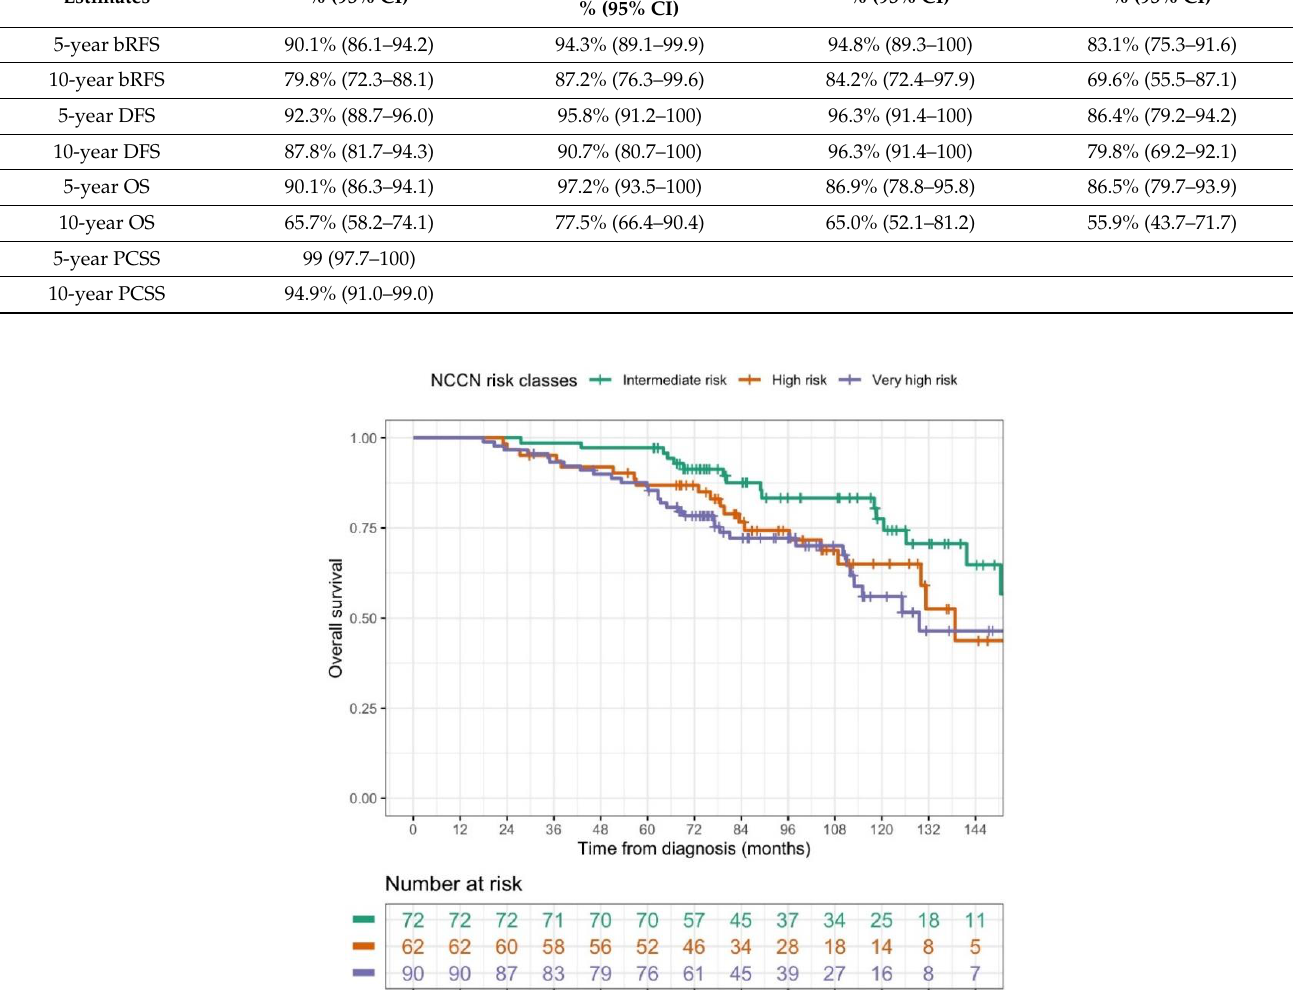
Table 2. Five- and 10-year biochemical relapse—(bRFS), disease free—(DFS), overall—(OS), and -prostate cancer-specific survival (PCSS) in percentages with 95% confidence intervals (CIs). Kaplan–Meier estimates were reported for all patients and within NCCN risk classes. PCSS stratified analysis was not performed due to the small number of events. Kaplan Meier Estimates